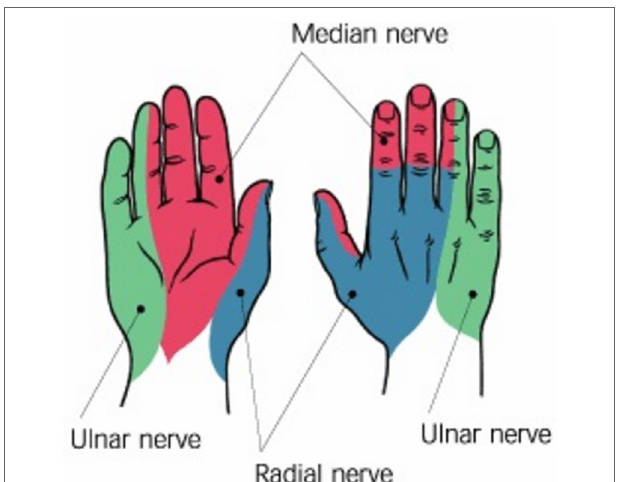
FiGURe 6 | Nerves in the hand: radial, median, and ulnar (Peripheral nerves of the upper extremity. OrthopaedicsOne Clerkship. In: OrthopaedicsOne – The Orthopaedic Knowledge Network. Created November 25, 2010, 14:08. Last modified November 25, 2010, 14:08 ver.2. Retrieved June 23, 2017, from http://www.orthopaedicsone.com/x/Q4DEAg).